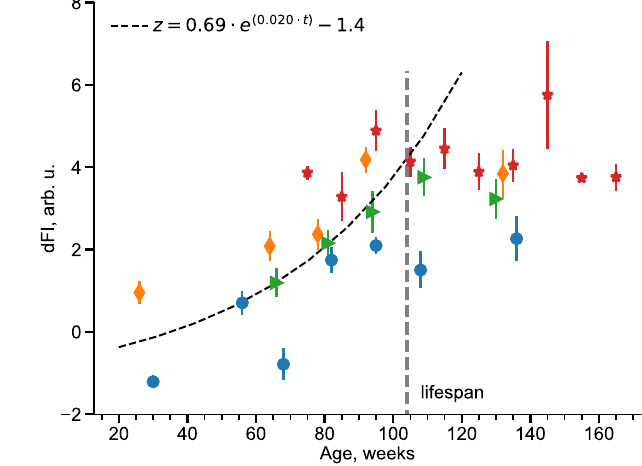
Fig.3 |Thedynamicfrailtyindicator(dFI)asafunctionofage. The dependence of the dFI from age in the validation datasets from the experiments: MA0071 (males, orange diamonds), MA0071 (females, blue circles), and MA0072 (green triangles). The black dashed line is the exponential fi t in the age groups younger than the average lifespan of NIH Swiss mice (indicated by the vertical grey dashed line). Red stars mark the average dFI in age-matched groups of frail animals from the MA0073 cohort. All data are presented as